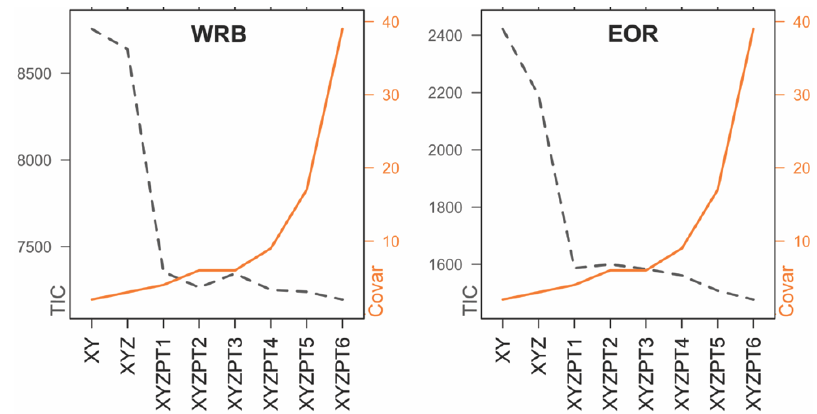
Figure 3. Spatial generalized extreme value (GEV) model fit for both regions. Grey dashed line represents TIC, while the solid orange line represents the number of model covariates.